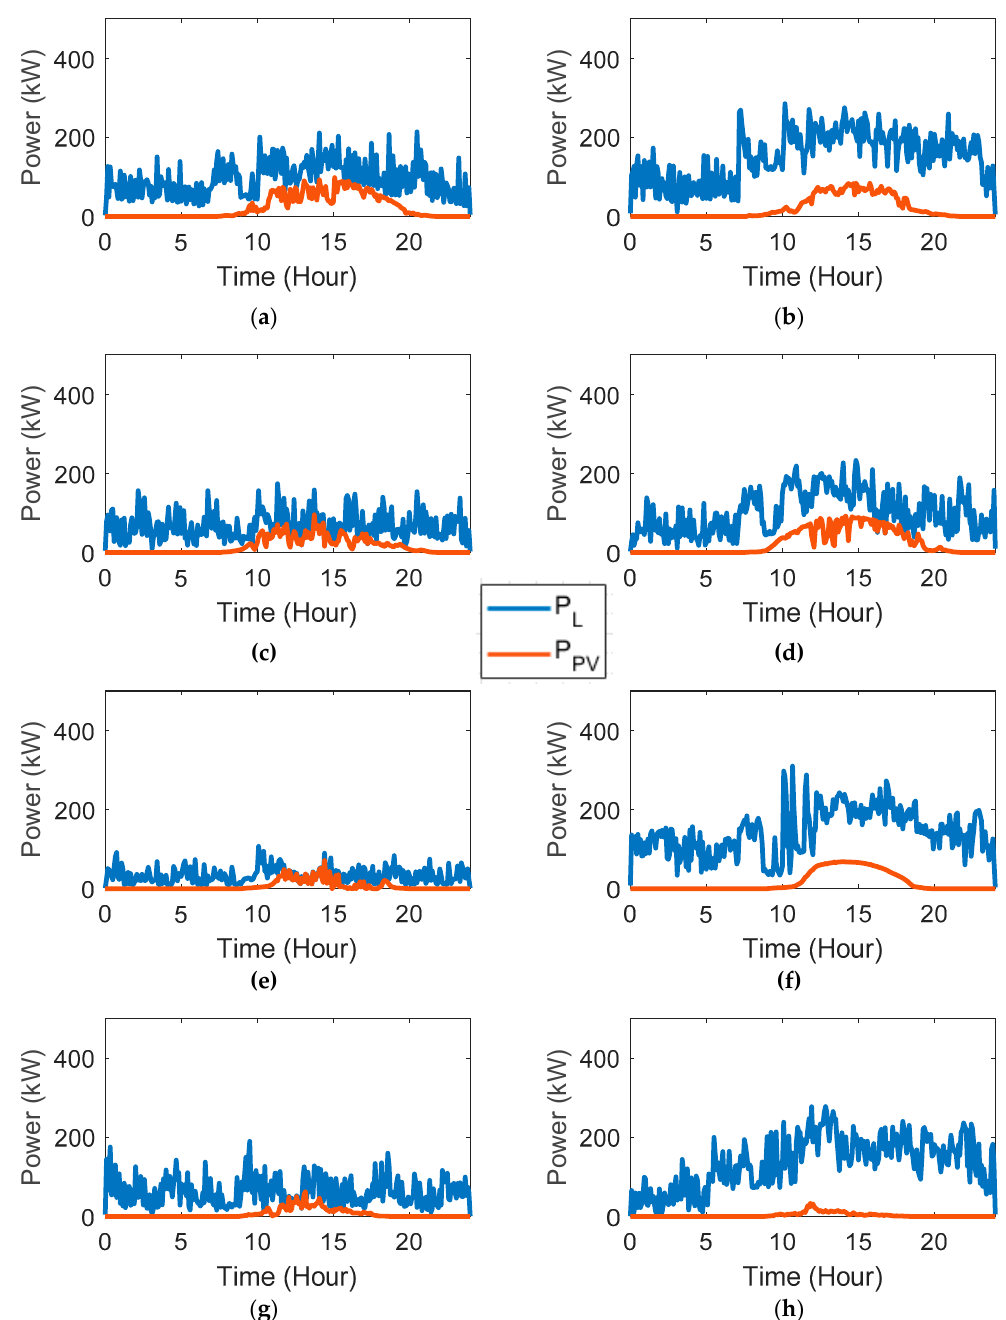
Figure 4. Load and photovoltaic generation profiles. Industry B.( a ) Weekend-May 6; ( b ) Labor Day-May 4; ( c ) Weekend-July 30; ( d ) Labor Day-July 31; ( e ) Weekend-October 22; ( f ) Labor Day-October 26; ( g ) Weekend-February 5; ( h ) Labor Day-February 6.